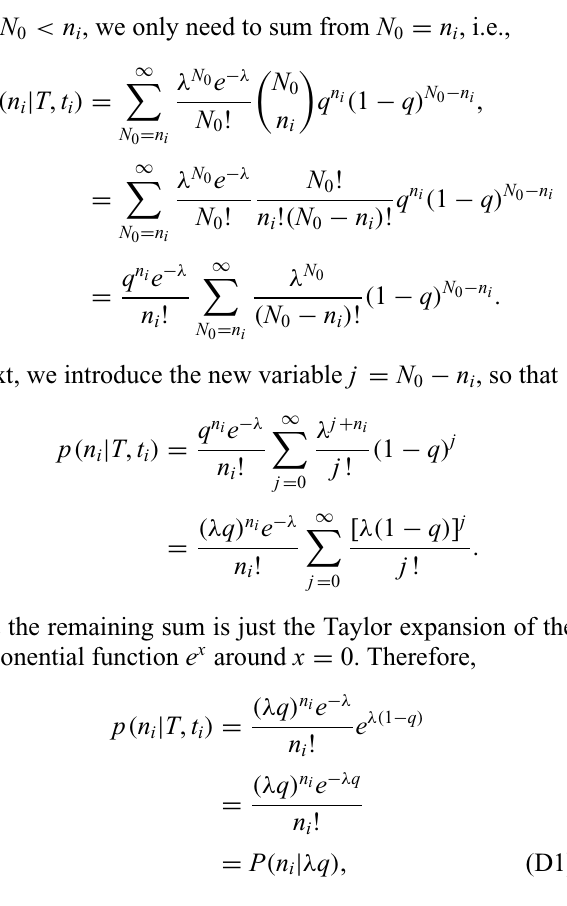
FIG. 7. Regime of validity of Eq. (C1) for the recaptured fraction. The analytical approximation (C1) (blue) is compared to the recaptured fraction computed from 5000 individual simulated trajectories of atoms sampled from a thermal distribution (orange), as a function of temperature, for different recapture times. Axial motion due to gravity is also factored in the calculation. As can be seen, for a deep trap with U 0 / k B = 290 μ K (top row), the approximation holds well up to about 125 μ K, while it breaks down at about 30 μ K in a shallow-trap configuration (bottom row) with U 0 / k B = 110 μ K. Simulations are for 41 K and the trap geometry described in Sec. III